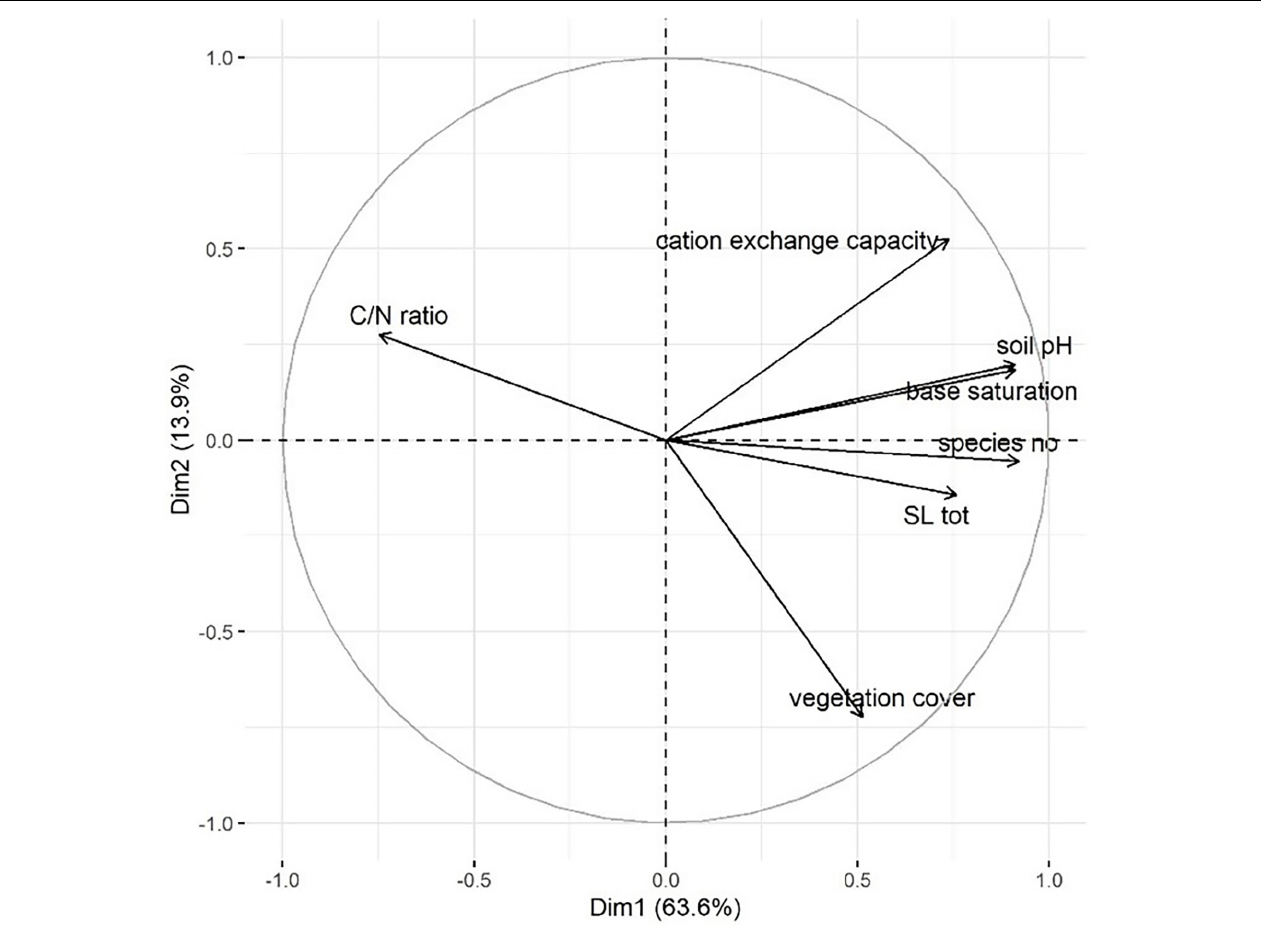
FIGURE 3 | PCA correlation circle using A montana total SL contents and related environmental and vegetation parameters. PCA dimensions 1 and 2 are plotted. Correlations of the variables with the PCA dimensions are illustrated by the arrows; arrow direction is linked to the correlation with a certain PCA dimension, arrow length indicates strength of